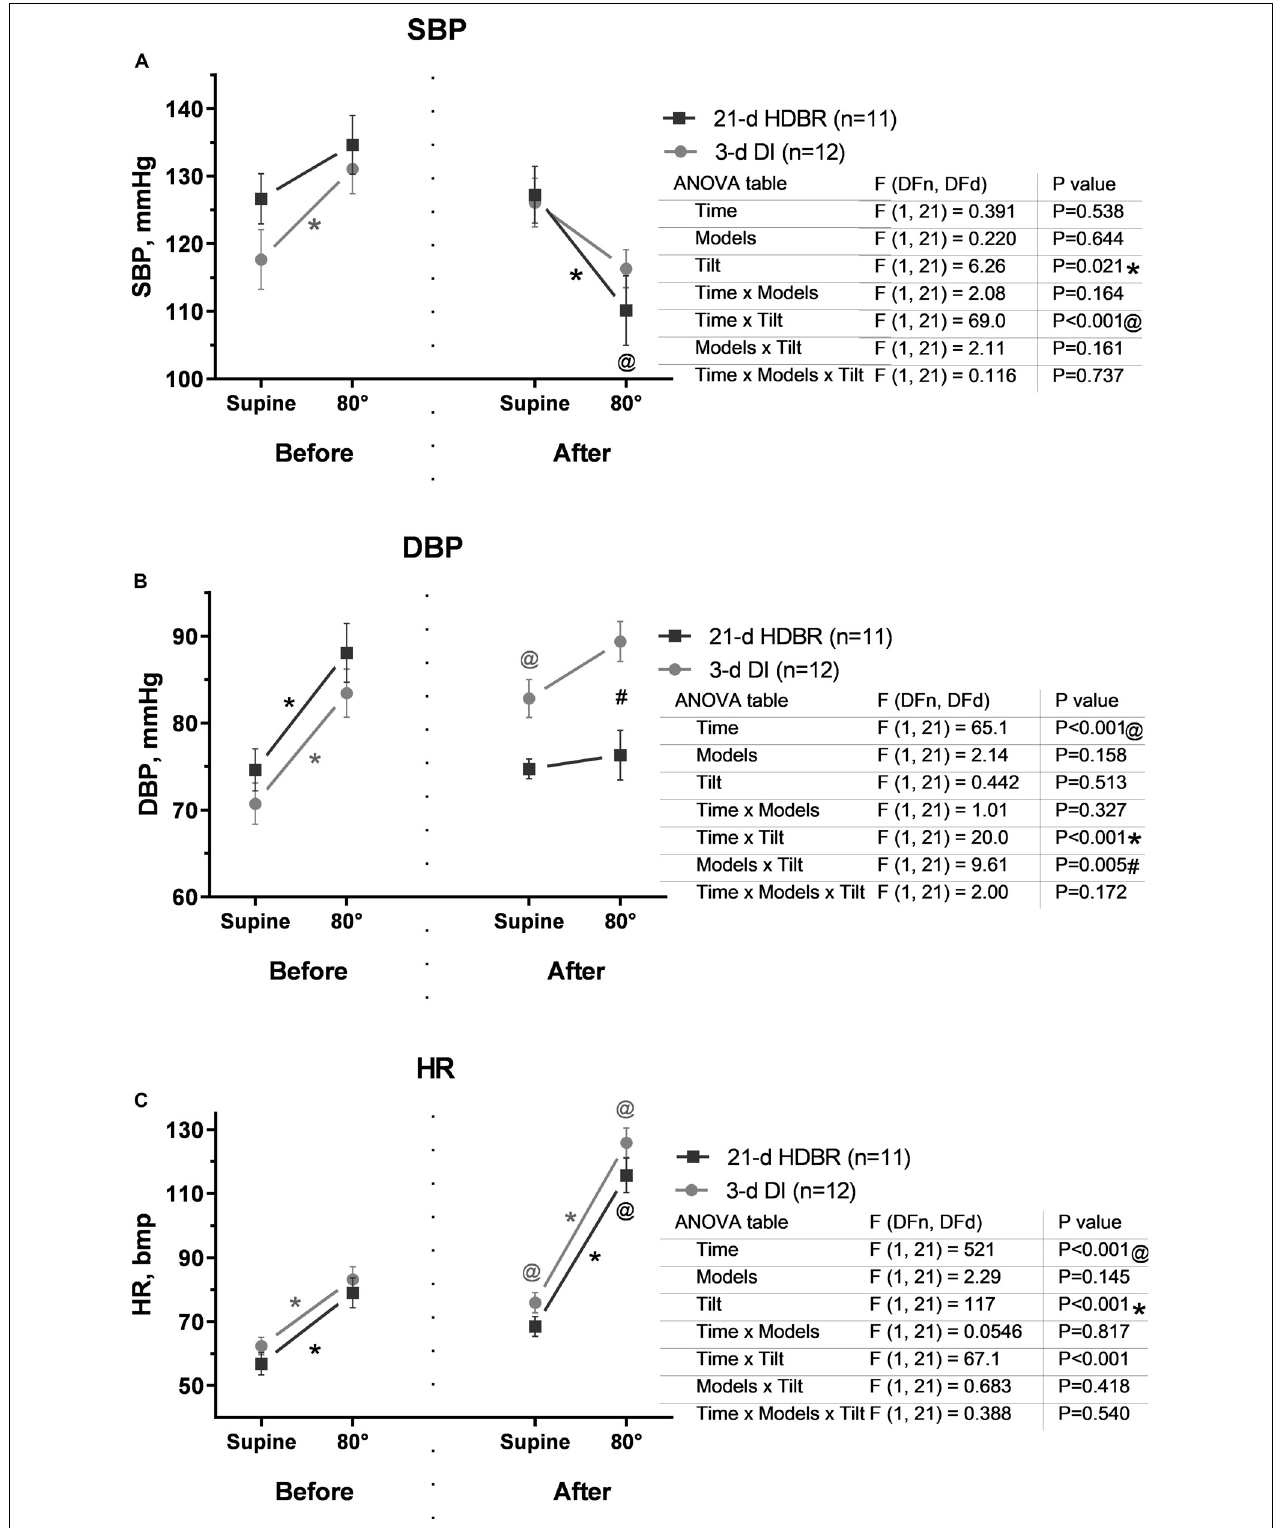
FIGURE 4 | Changes in systolic blood pressure (A) , diastolic blood pressure (B) , and heart rate (C) in response to the 80 ◦ tilt test before and after the 21-day head-down bed rest (HDBR) and 3-day dry immersion (DI). Data are the mean ± SEM. # p < 0.05 between groups; * p < 0.05, 80 ◦ vs. the supine position; @ p < 0.05, before vs. after